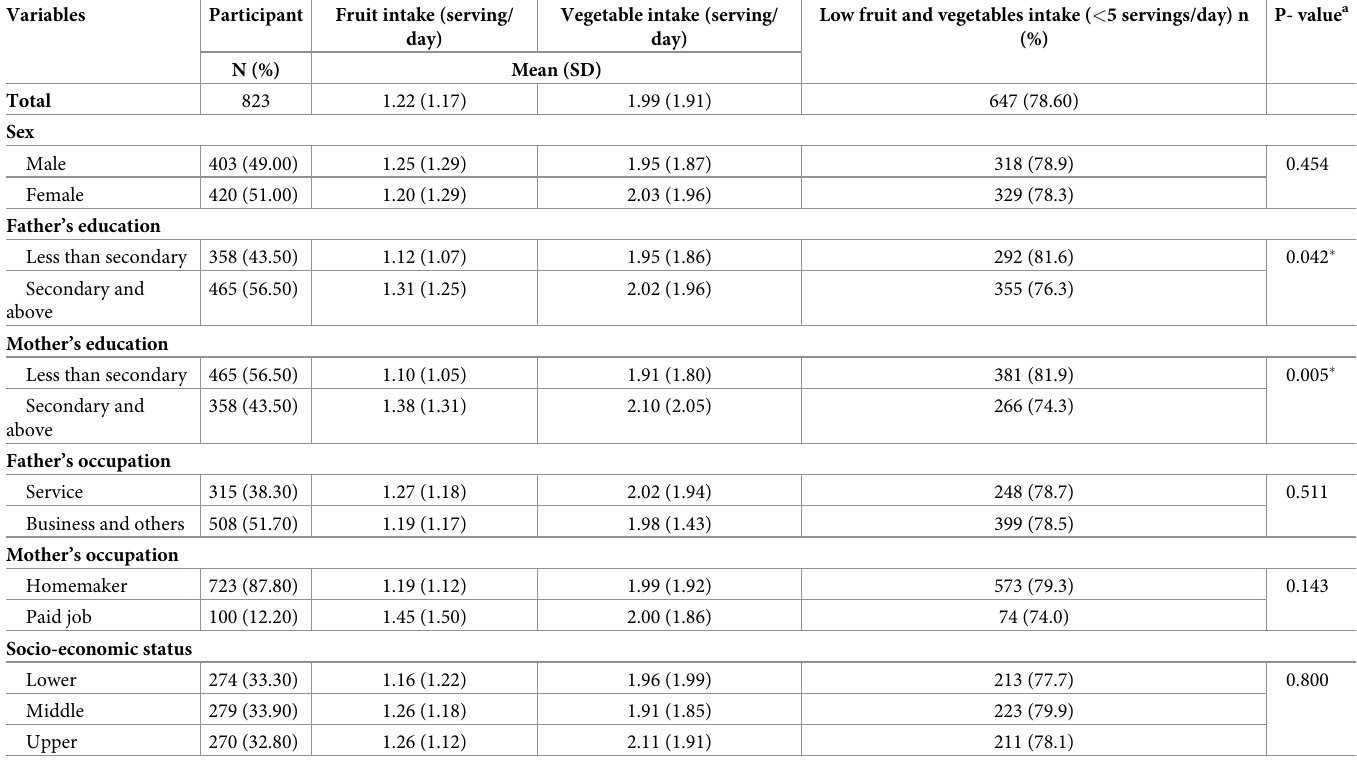
Table 2. Adolescents’ fruit and vegetables intake across different socio-demographic